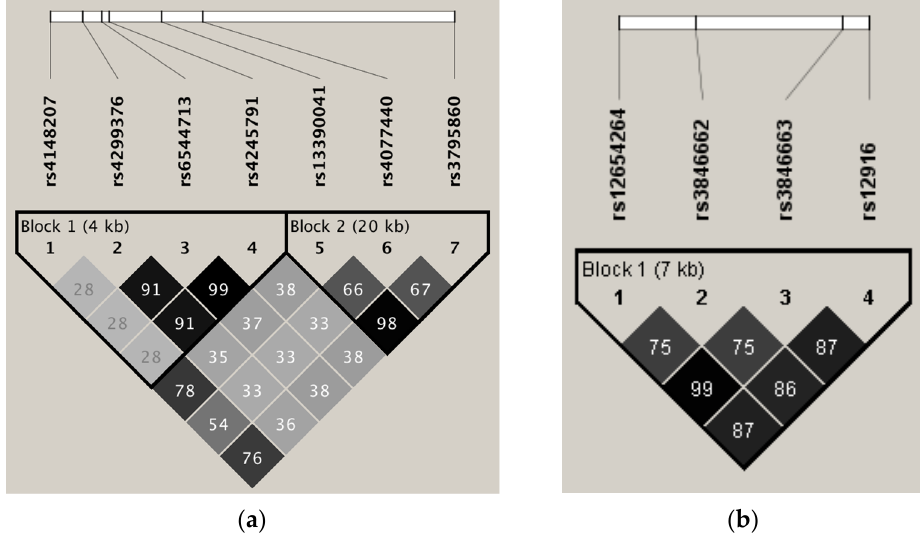
Figure 1. Pairwise LD among ( a ) 7 SNPs in ABCG8 and ( b ) 4 SNPs in HMGCR is indicated in the diamond shapes. The triangles mark the two haplotype blocks within this region (based on the confidence interval of D’). The shading with a dark grey to white gradient indicates the level of higher to lower LD between each pair of SNPs based on the r 2 -value. The LD plot was created by Haploview version 4.1 [35] .